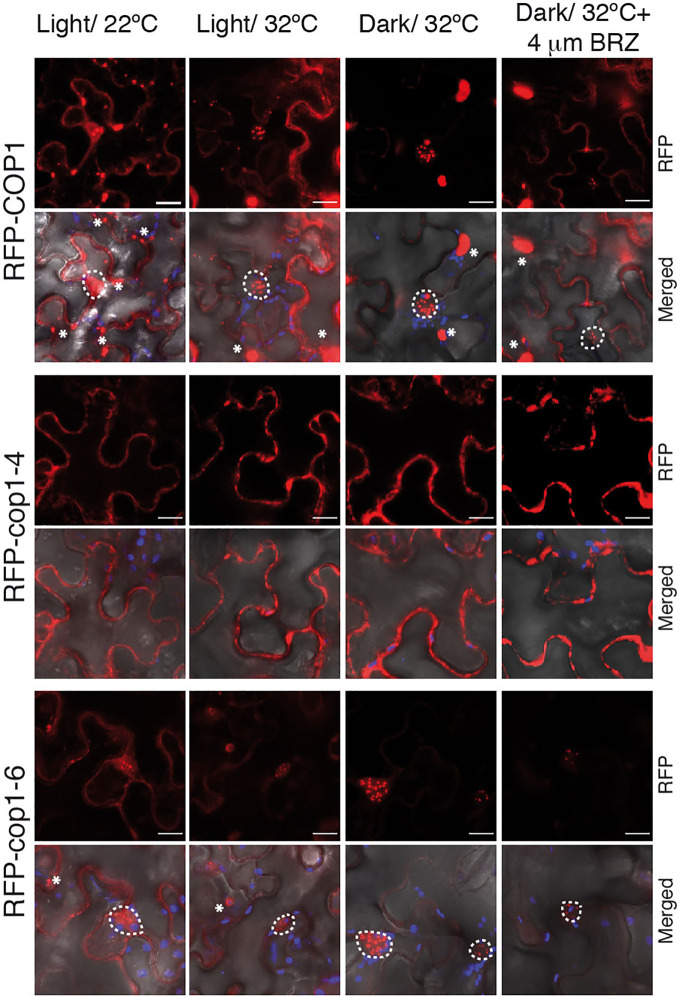
BRZ application results in nuclear depletion of COP1. Subcellular distribution of COP1 in N. benthamiana leaves. The RFP-tagged COP1, cop1-4 and cop1-6 proteins were agroinfiltrated in N. benthamiana leaves and visualized by confocal microscopy. COP1 is mainly localized in the cytoplasm and shows a diffuse nuclear signal at 22°C, in the light. After 24 h exposition to dark and warm temperatures (set to 32°C for N. benthamiana), COP1, and cop1-6 are shuttled to the nucleus. Leaves incubated at 32°C in the light showed a partial COP1 and cop1-6 nuclear import. Nuclear COP1 forms nuclear bodies, whereas cop1-6 has a more diffused nuclear pattern, with occasional distribution in speckles. BRZ treatment however leads to a reduction in nuclear abundance of both proteins. RFP-cop1-4 lacks the NLS signals and is localized in the cytoplasm. RFP signal is shown in red, chloroplasts auto-fluorescence in blue and bright field in grey. Scale bars = 15 µm. Nuclear signal is delimited by white circles, whereas cytosolic bodies are indicated with asterisks.